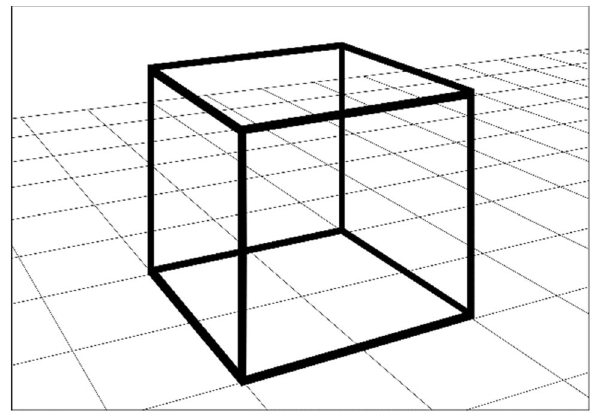
Figure 4. 3D model of the object.